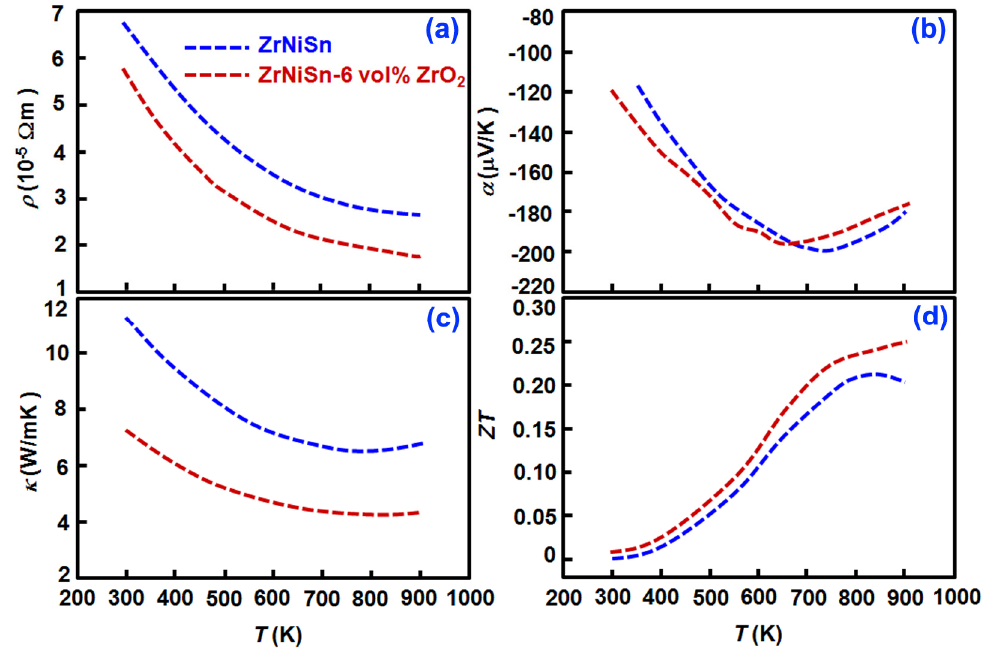
Figure 6. Thermoelectric (TE) transport properties of ZrNiSn-ZrO ( a ) resistivity; ( b ) the Seebeck coefficient; ( c ) thermal conductivity; and ( d ) ZT values. The data is adopted from Reference